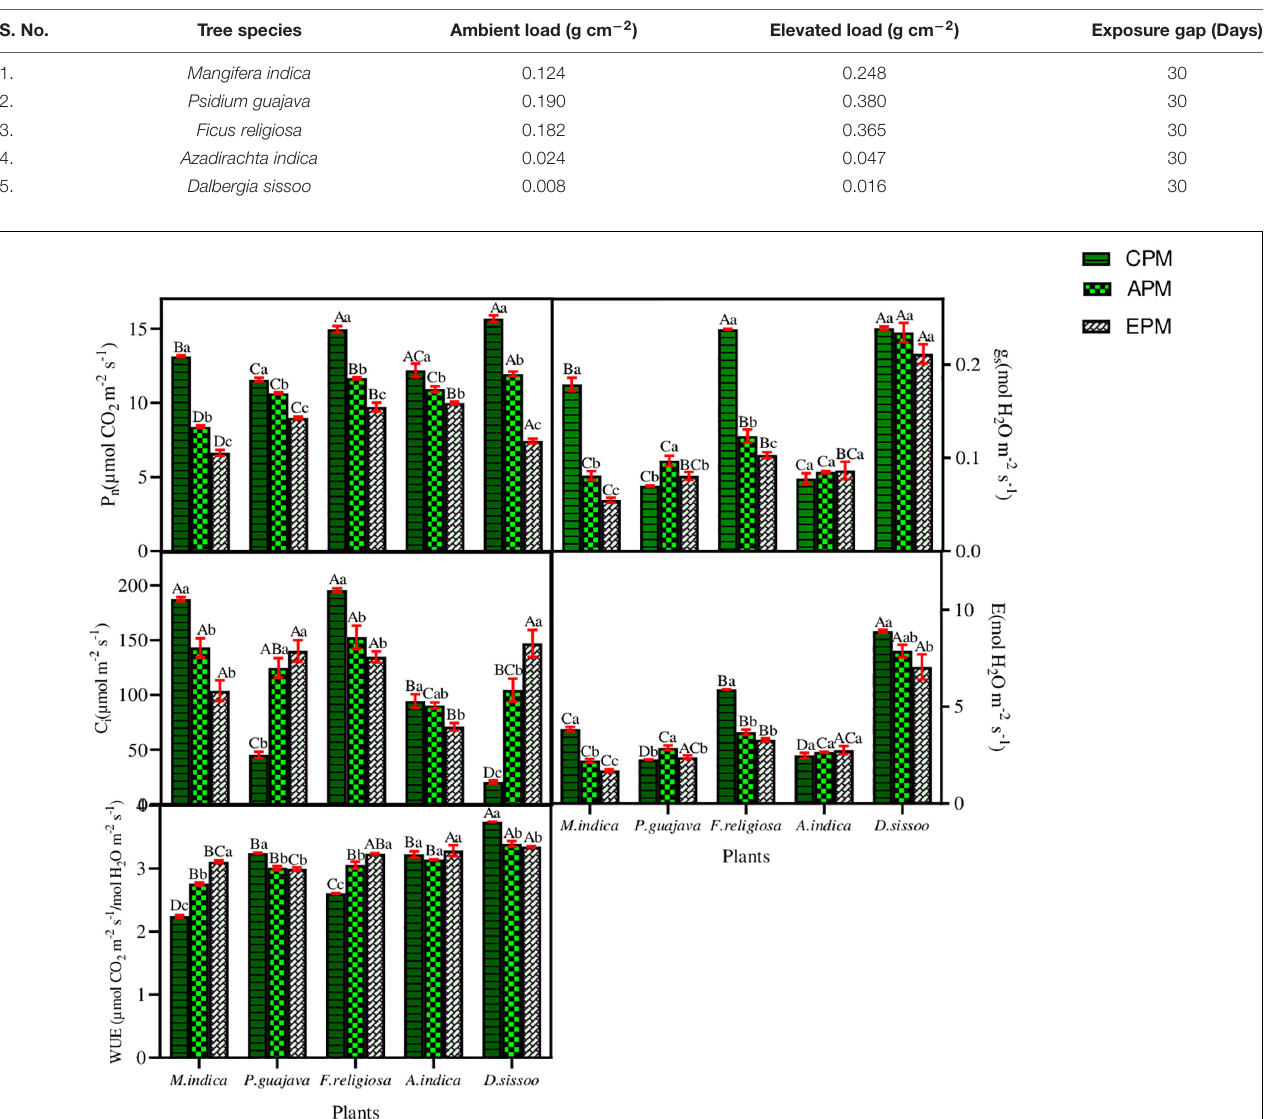
FIGURE 3 | The photosynthetic parameters of different tree species under different PM treatments. Different letters in uppercase indicate a significant difference between PM treatments for different tree species ( p < 0.05) and different lowercase letters indicate a significant difference between the treatments of a species ( p <